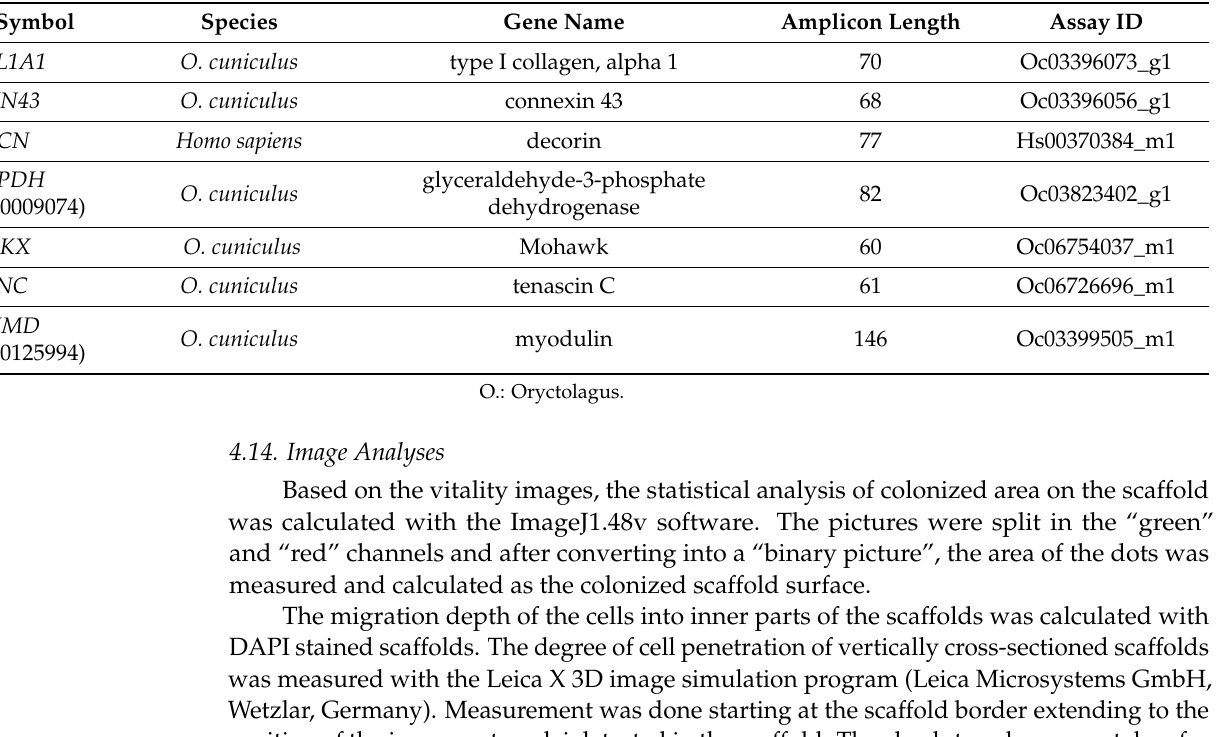
Table 2. Primer list for gene expression